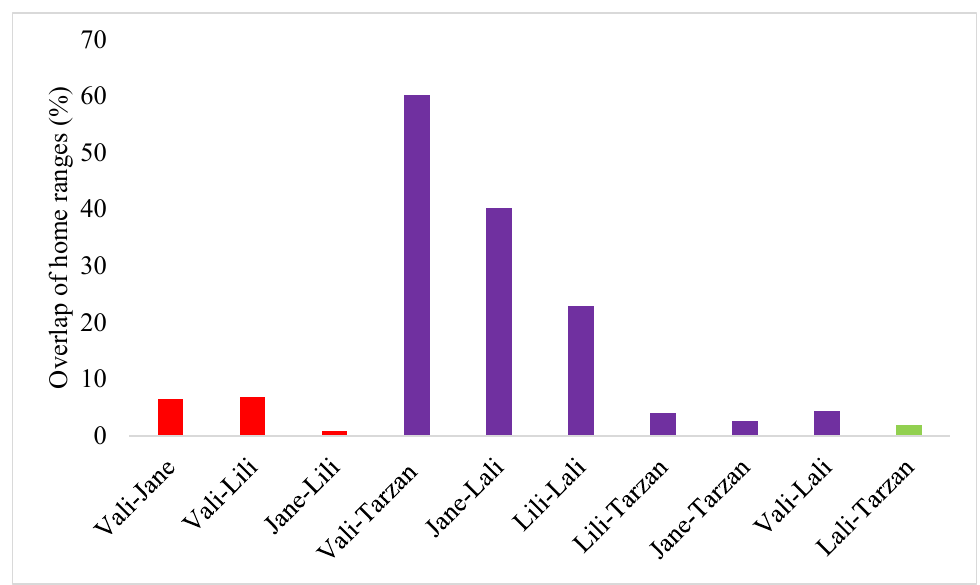
Figure 5. Overlap of the individual home ranges of Caspian whipsnakes ( Dolichophis caspius ) as a percentage of the total area covered by the home ranges of the pairs (%), calculated using MCP during the activity period. (Red—female-female overlap, purple—female-male overlap and green—male-male overlap).